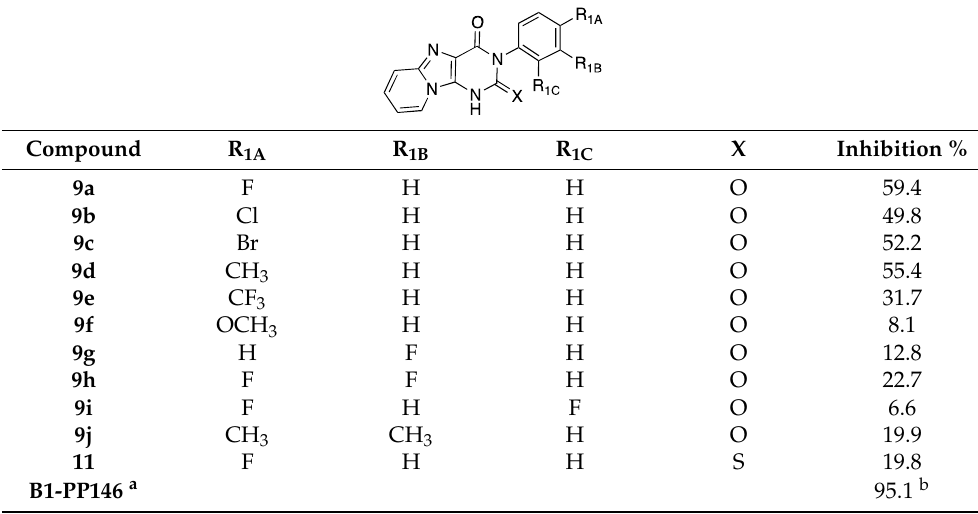
Table 1. SAR at the N 3 -position by phenyl derivatives 9a–j and 11 and the Mtb ThyX inhibition at 200 µM by the NADPH oxidase assay.